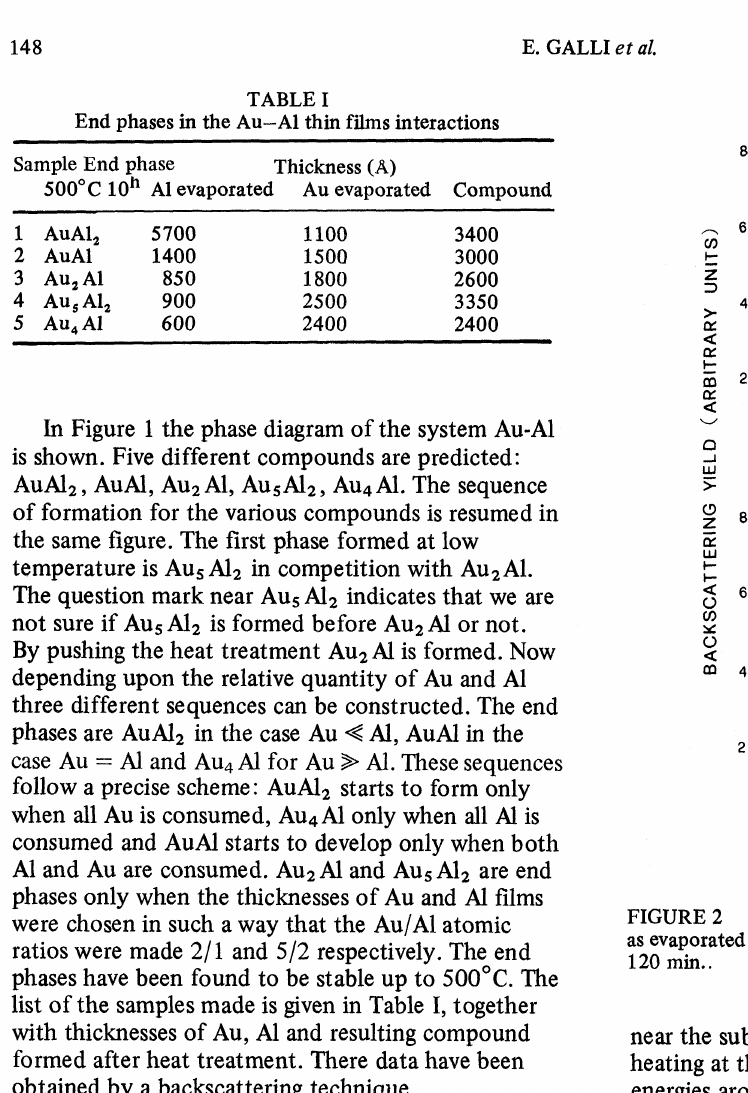
TABLE End phases in the Au-A1 thin films interactions